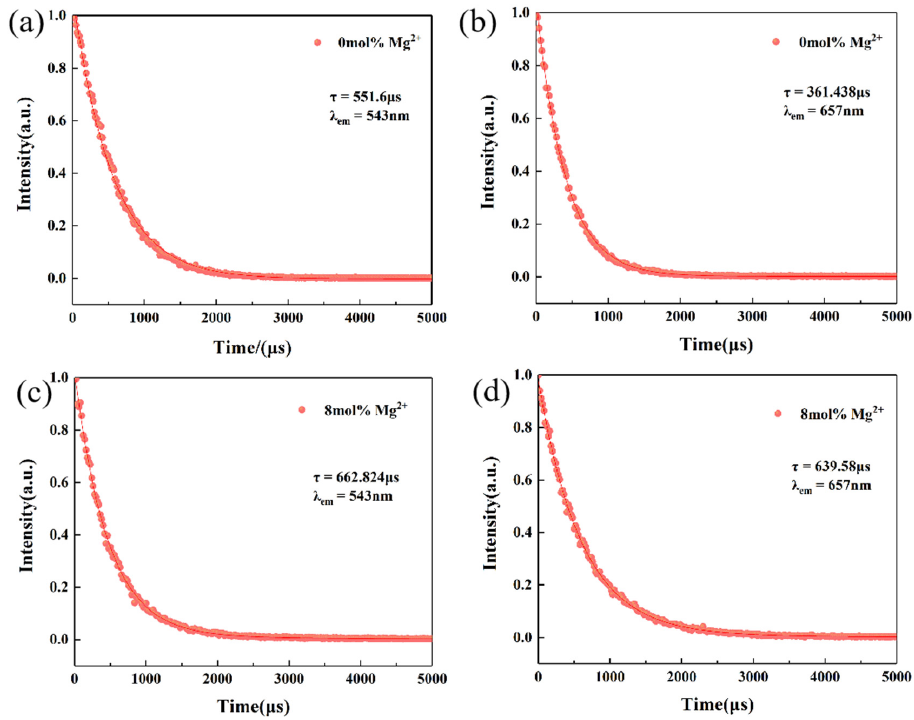
Figure 6. The upconversion fluorescence lifetime decay curves of LiYF 4 :Yb 3+ /Ho 3+ UCMPs doped with ( a ) 0 mol% and ( c ) 8 mol% Mg 2+ at 543 nm. The upconversion fluorescence lifetime decay curves of LiYF 4 :Yb 3+ /Ho 3+ UCMPs doped with ( b ) 0 mol% and ( d ) 8 mol% Mg 2+ at 657 nm. Photonics 2022 , 9 , x FOR PEER REVIEW Figure 7a shows the screen-printing process of making anti-counterfeiting charac- ters. Firstly, LiYF 4 :Yb 3+ /Ho 3+ micron crystal particles doped with a Mg 2+ ion concentration of 8 mol% were selected as the raw material for anti-counterfeiting ink. The ground Li- YF 4 :Yb 3+ /Ho 3+ /Mg 2+ micron crystal powder was evenly mixed with mesh metal ink to make anti-counterfeiting ink, which was prepared at a ratio of 5:1 (samples:ink). Finally,